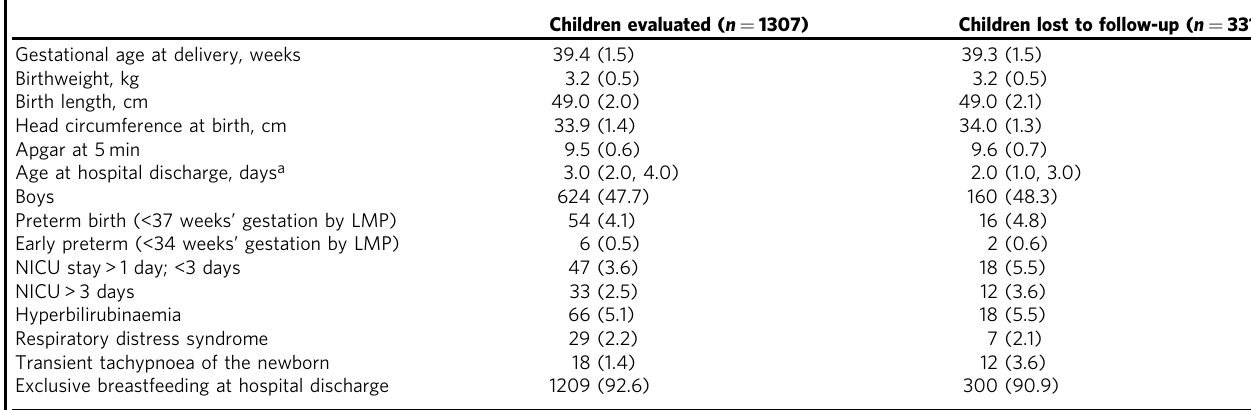
Table 1 Neonatal characteristics of children included in the INTERGROWTH-21 st Neurodevelopment Assessment Study compared to children lost to follow-up Children evaluated ( n = 1307) Children lost to follow-up ( n = 331) Gestational age at delivery,